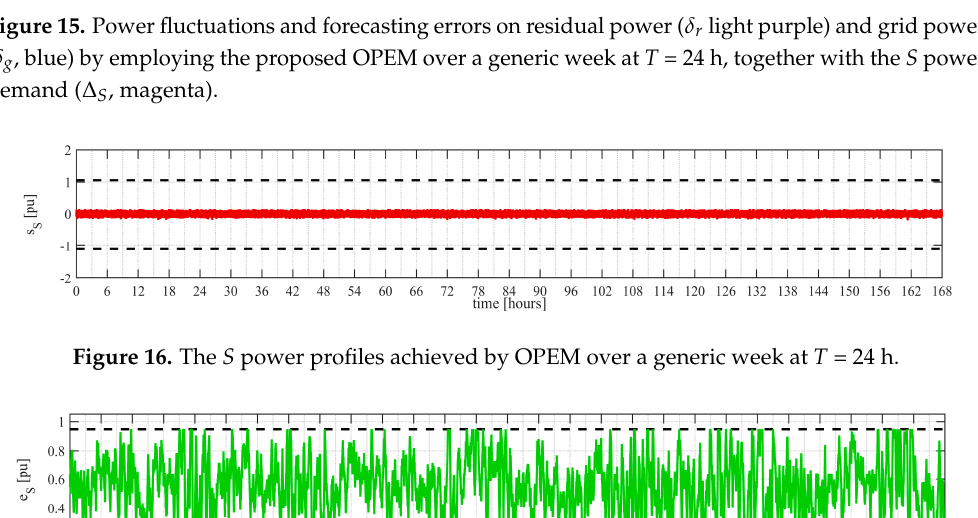
Figure 17. The S energy evolution achieved by OPEM over a generic week at T = 24 h.